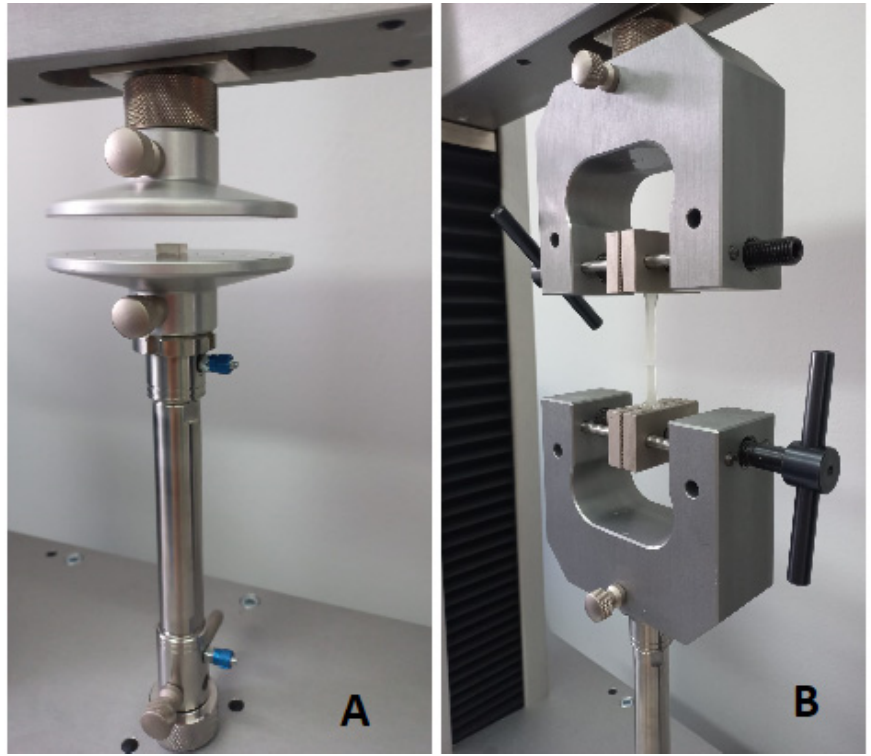
Figure 2. Illustration of the samples tested in the Universal Testing Machine during the ( A ) com- pression test and ( B ) tensile test sion test and ( B ) tensile test.